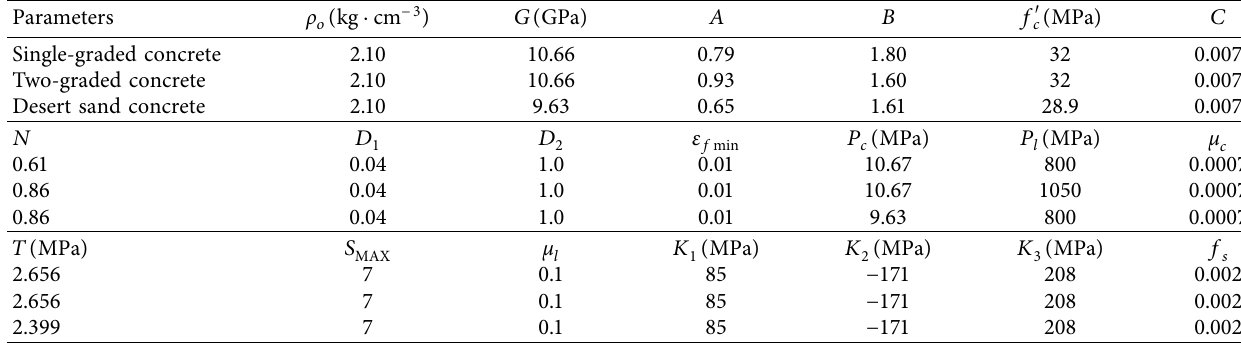
Figure 5: Finite element models. (a) Desert sand concrete. (b) Single-graded concrete. Table 5: Model parameters for cement mortar.